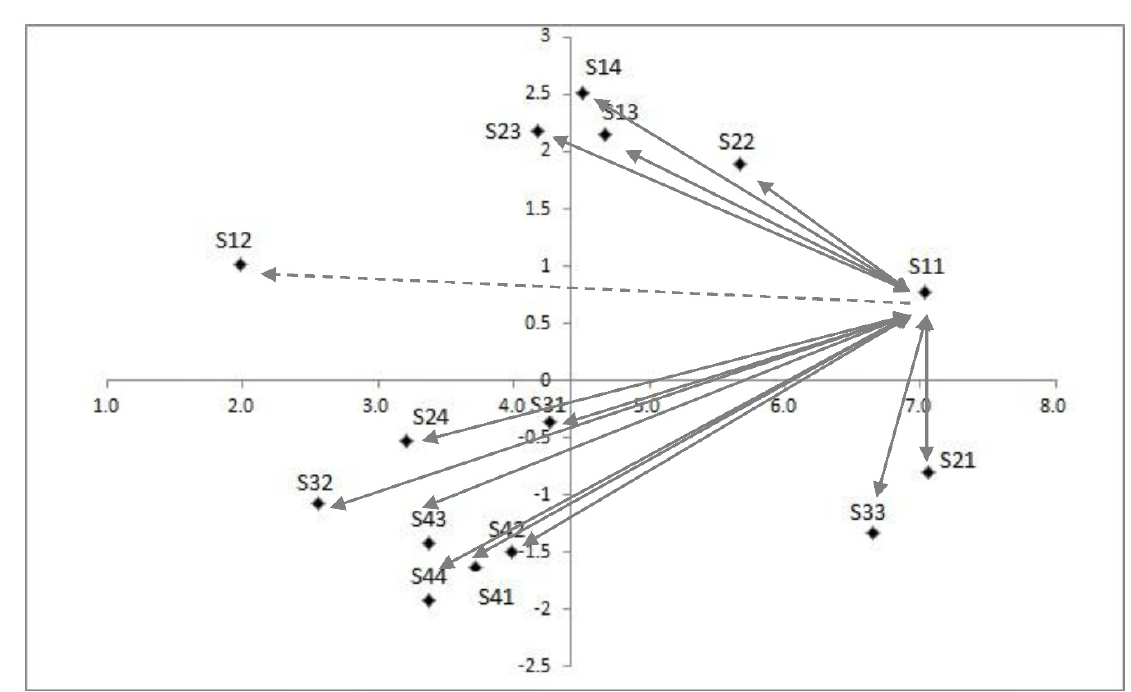
Figure A1. Casual Diagram between S11 and Other Criteria.